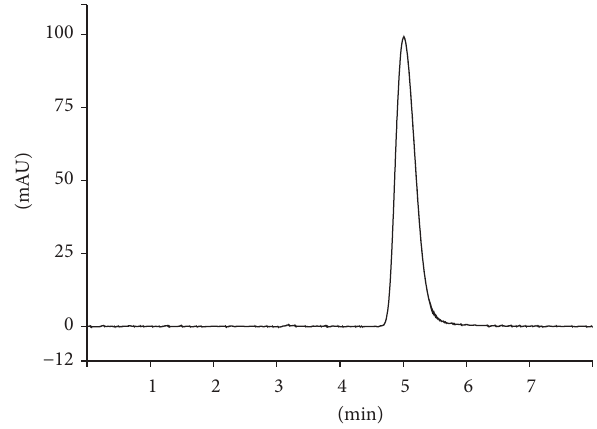
Figure 2: Representative HPLC chromatogram of ferulic acid standard (40 𝜇 g/mL) in methanol :water adjusted to pH 3.0. Mobile phase: methanol :water adjusted to pH 3.0 using ortho phosphoric acid (48: 52 v/v); flow rate: 1.0mL/min; detection wavelength: 320 nm; column temperature: 25±2 ∘ C; and injection volume: 10 𝜇